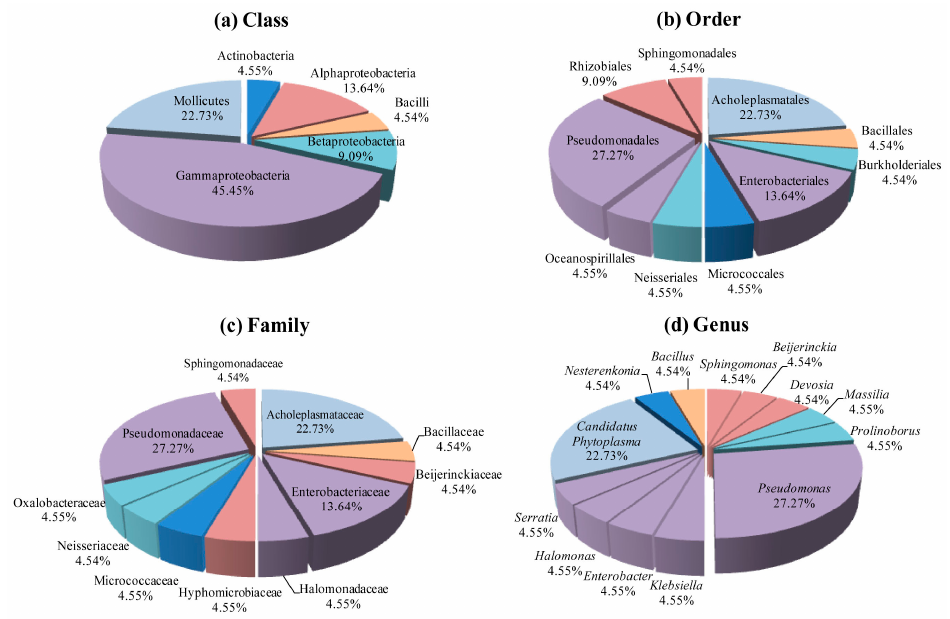
Figure 5. Different levels of relative abundances of B. ischaemum phyllosphere bacteria. ( a ) Class; ( b ) Order; ( c ) Family; and, ( d ) Genus.